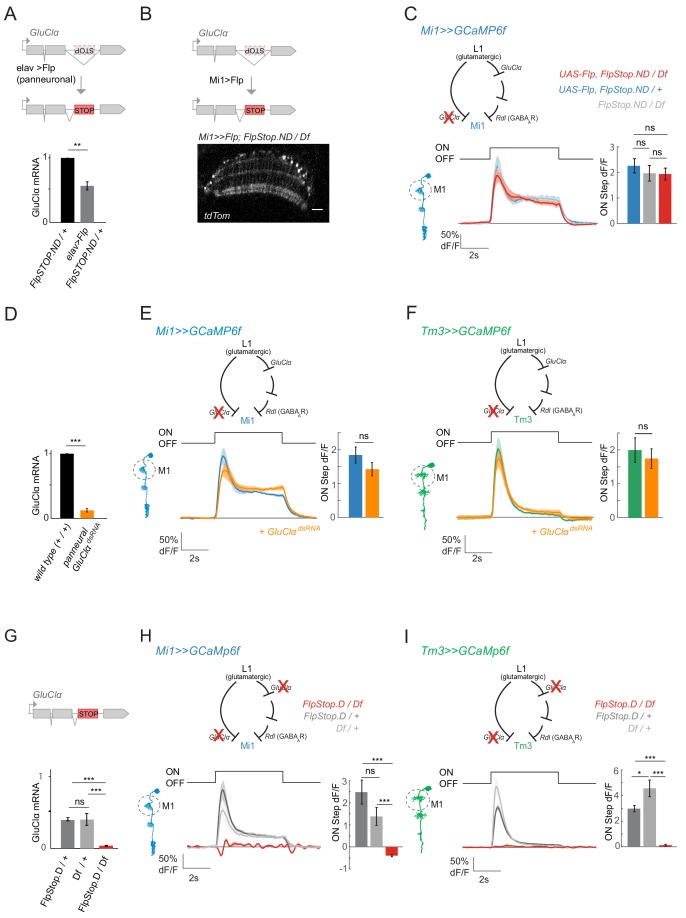
ON selectivity is a multisynaptic computation mediated by GluClα.(A) Schematic illustrating inversion of the GluClα FlpStop exon in all neurons by panneuronal expression of Flp recombinase using elav-Gal4. qRT-PCR results show GluClα mRNA levels relative to the GAPDH housekeeping gene, normalized to controls. (B) The FlpStop exon in the non-disrupting (ND) orientation was inverted specifically in Mi1 neurons by cell-type-specific expression of Flp recombinase. This is visualized via expression of tdTom signal, and is specific to and broad in Mi1. (C) In vivo calcium signals recorded in a cell-type-specific Mi1 GluClα loss-of-function. Calcium signals were recorded in layer M1 of GluClα mutant Mi1 neurons (n = 5 (136)) (red), and heterozygous controls (n = 5[166], n = 5[139]) (blue, gray). The bar plot shows quantification of the ON step. (D) qRT PCR results quantifying pan neuronal knockdown of UAS-GluClαRNAi using elav-Gal4, normalized to control. (E,F) In vivo calcium signals upon cell-type-specific GluClα knockdown. Calcium signals in response to full-field flashes were recorded in layer M1 of (E) Mi1 control (n = 8[229]) or Mi1 >>GluClαRNAi (n = 6[215]) or of (F) Tm3 control (n = 8[150]) and Tm3 >>GluClαRNAi (n = 6[146]). Bar plot show quantification. (G) qRT PCR results quantifying GluClα mRNA levels in heterozygous GluClαFlp.Stop.D/+ and GluClαDf/+, as well as the homozygous mutant GluClαFlp.Stop.D/Df. (H,I) In vivo calcium signals recorded in a full GluClαFlpStop.D mutant background (red). Heterozygous GluClαFlpStop.D controls are in blue (Mi1, n = 5 (117)) or green (Tm3, n = 8 (275)), heterozygous Df controls are in gray (Mi1, n = 5[142]; Tm3, n = 5[198]) and the experimental condition is in red (Mi1, n = 9 [134]; Tm3, n = 5[96]). Bar plots show quantification of the ON step response. All traces show mean ± SEM. All sample sizes are shown as number of flies (number of cells). Statistics was done using an unpaired Student t test for comparison in (A,D,E,F), and a one-way ANOVA and a post-hoc unpaired t-test with Bonferroni-Holm correction for multiple comparisons in (C,G,H,I). *p<0.05, **p<0.01, ***p<0.001.10.7554/eLife.49373.026Figure 7—source data 1.Table 1 contains all mean ± s.e.m.Data related to quantifications shown in main Figure 7, sorted by genotype and experimental condition.